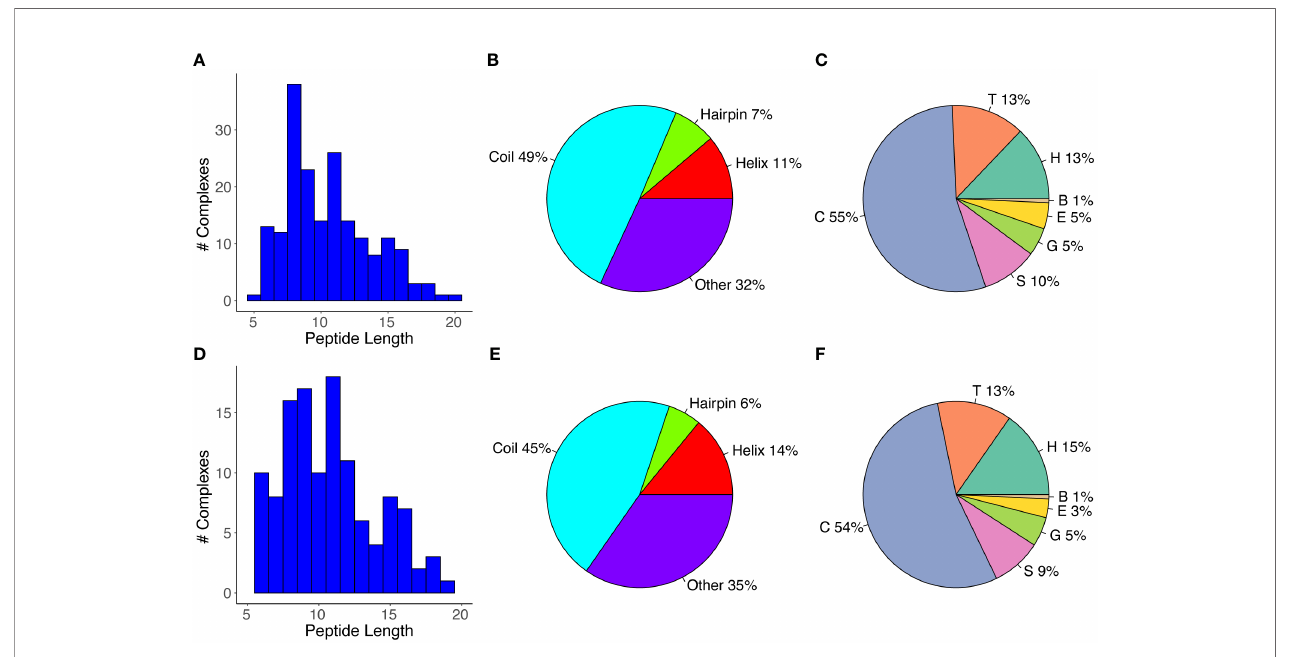
FIGURE 1 | Antibody-bound peptide lengths and secondary structures. (A) A histogram of the peptide residue lengths, (B) Peptide structural classes, and (C) Peptide residue DSSP structural classes are shown for the full set of antibody-peptide complexes (N = 188). The (D) Peptide lengths, (E) Peptide structural classes, and (F) Peptide residue structural classes are also shown for the “ nr_epitope ” complex set (N = 121), which corresponds to the full set of complexes fi ltered by grouping pairs or sets of complexes with matching peptide sequences and retaining one representative per pair/group. Peptide structural classes (B, E) were de fi ned based on DSSP (33) residue-level secondary structure assignments, as noted in the Methods, and peptide residue secondary structure classes (C, F) correspond to DSSP-assigned classes. Classes are a -helix ( “ H ” ), b -bridge ( “ B ” ), extended strand ( “ E ” ), 3 10 helix ( “ G ” ), turn ( “ T ” ), bend ( “ S ” ), and no regular secondary structure (loop/irregular; “ C ” ).